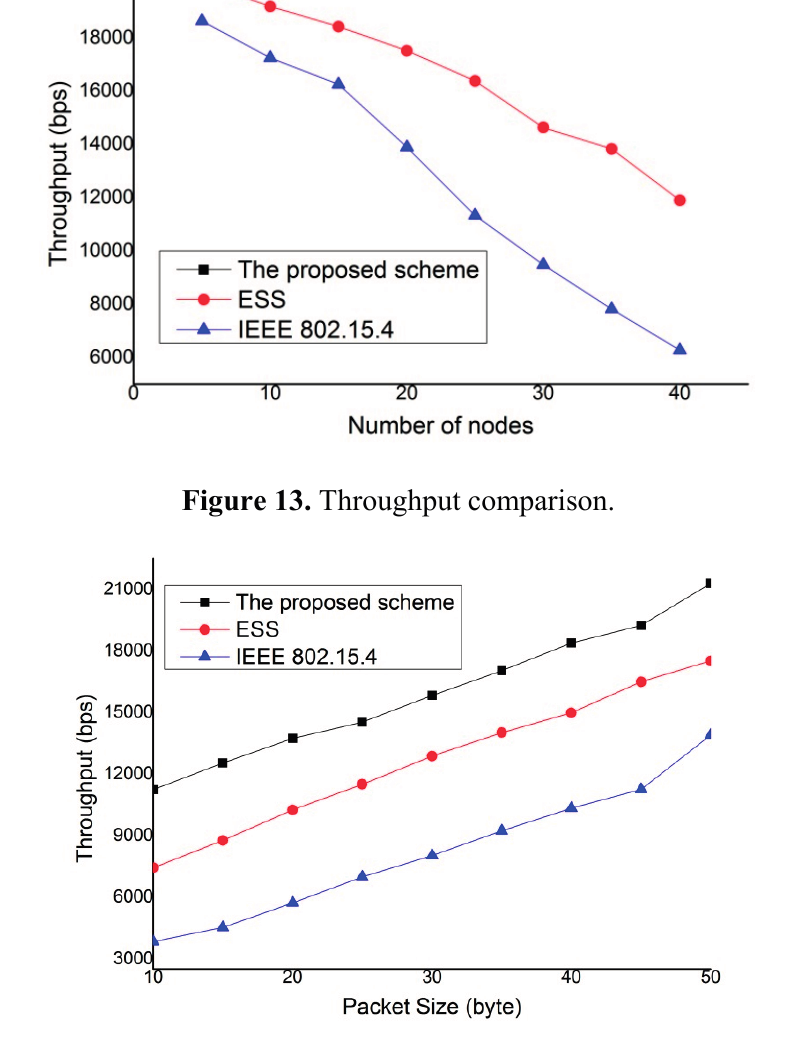
Figure 14. Variation of throughput with packet size given number of devices =